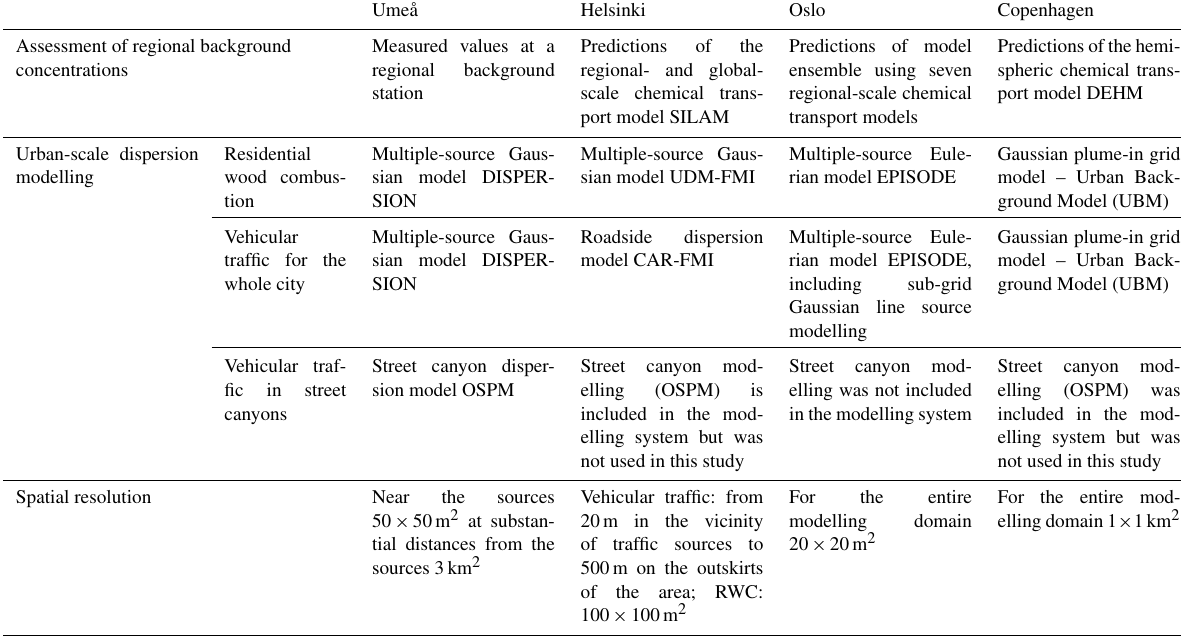
Table 3. Atmospheric dispersion modelling and its spatial resolution in the target